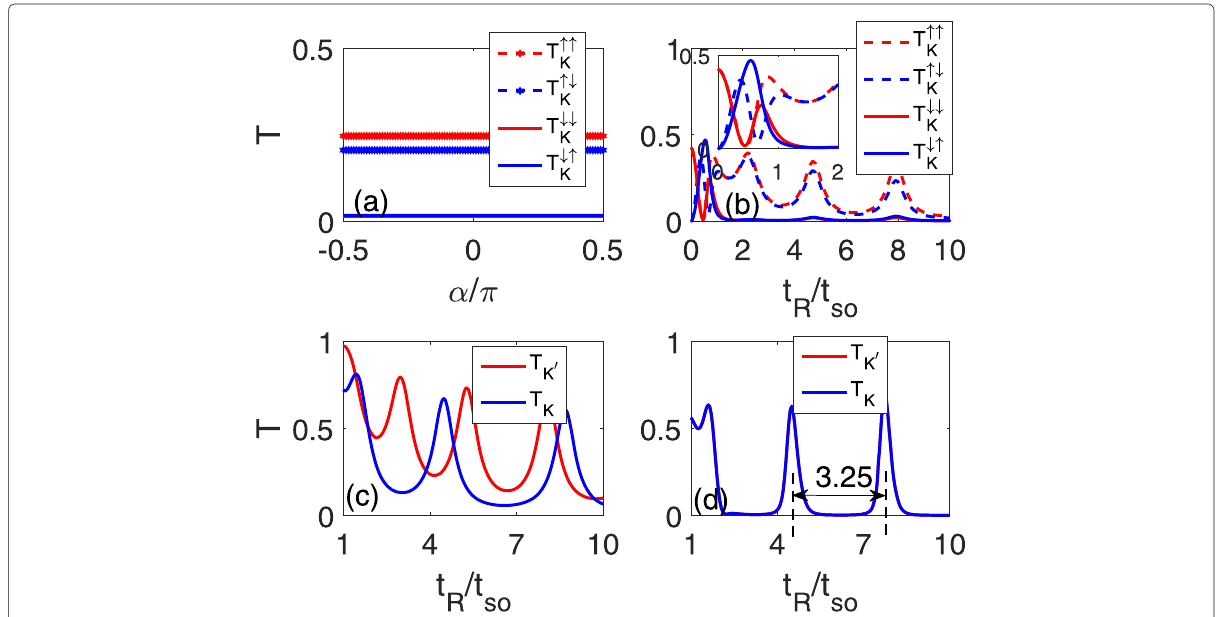
Fig. 2 Spin-conserved and spin-flip transmission coefficients as functions of the incident angles α at t R = 5 t so in a and as functions of the RSOC strength t R in b – d , where a - c are for the single line defect and d is for the two parallel line defects, with (cid:10) z = 0.2 t so in